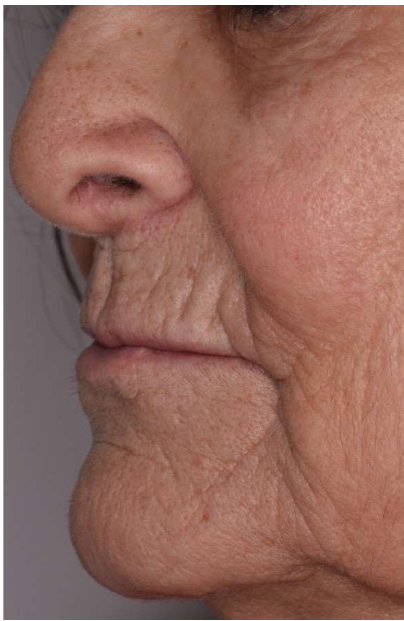
Figure 1. Typical profile of the total edentulous patient, without prosthetic restoration: the chin is projected forward, and the lips are thin and crushed.